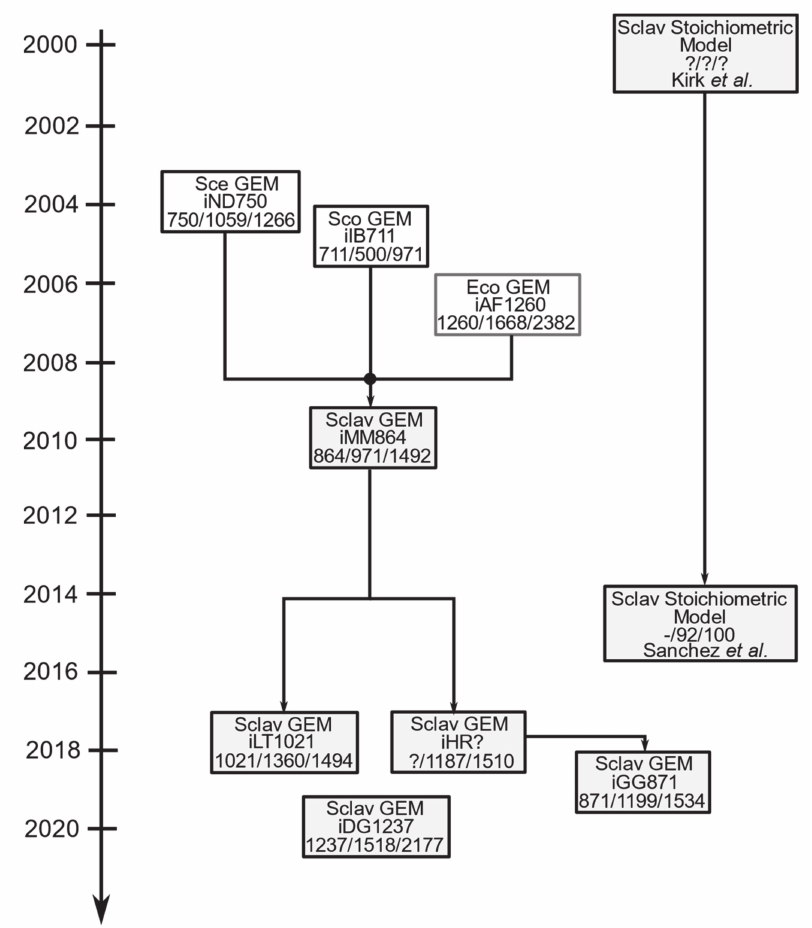
Figure 4. The evolution of S. clavuligerus metabolic models. Species abbreviations are Sclav: Strep- tomyces clavuligerus , Sco: Streptomyces coelicolor , Sce: Saccharomyces cerevisiae , Eco: Escherichia coli . Similarly, number of genes, metabolites, and reactions were included after a/symbol,